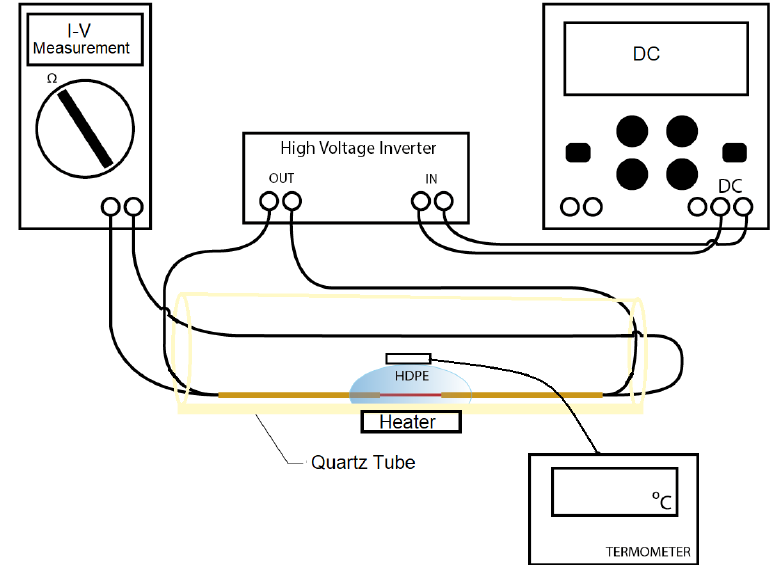
Figure 1. The schematic presentation of the experimental setup.